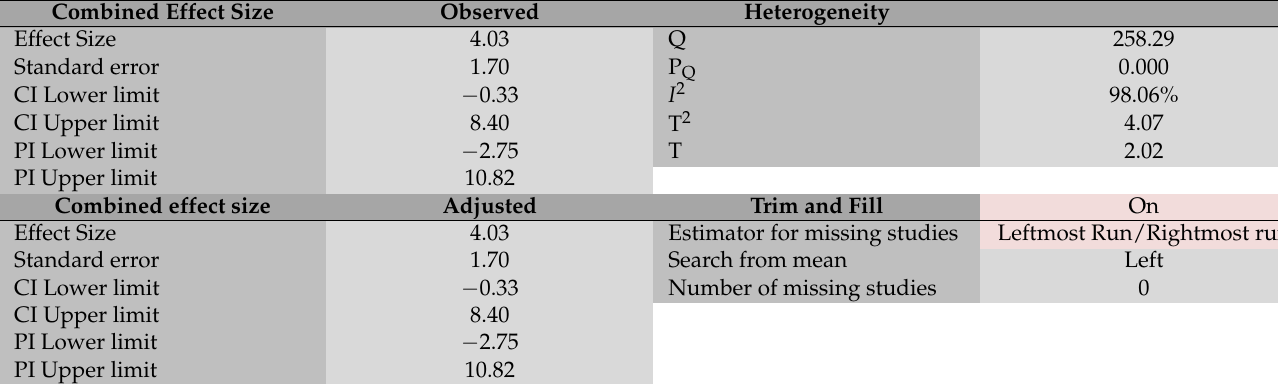
Table 5. Publication bias analysis confirming effect sizes and I 2 values.